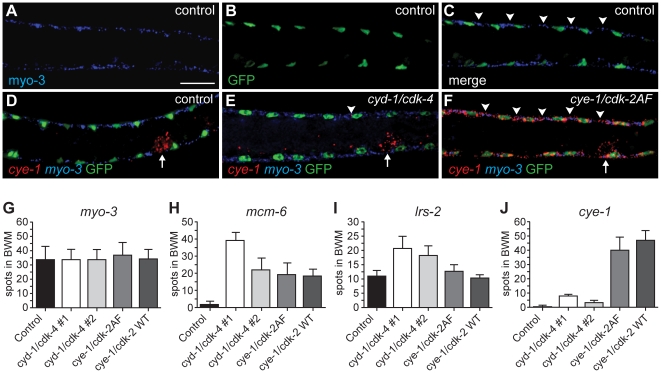
Single molecule FISH shows gene expression in individual muscle cells and limited cye-1 induction by CYD-1/CDK-4.(A-F) Single mRNA molecules labeled with probes against myo-3 (blue) or cye-1 (red) mRNA. Muscle nuclei are marked in green by myo-3::H2B::GFP. Analyzed are strains expressing only Pmyo-3::H2B::GFP (control, SV859: A-D), and Pmyo-3::H2B::GFP together with Pmyo-3::CYD-1/CDK-4 (SV857: E) or Pmyo-3::CYE-1/CDK-2AF (SV858: F). Arrowheads indicate areas of myo-3 mRNA (C) or cye-1 mRNA (E, F) expression in dorsal body-wall muscle cells. Arrows in (D-F) indicate cye-1 expression in the gonad. Scale bar indicates 10 µm, all panels show the same magnification. (G-J) Quantification of the number of fluorescent spots in seven body-wall muscle cells located anterior of the gonad on the dorsal side of animals. All animals were hybridized with myo-3 probes to identify body-wall muscle cells. Signal corresponding to mRNA molecules of myo-3 (G), mcm-6 (H), lrs-2 (I), or cye-1 (J) were counted. The strains analyzed are SV859 (control), SV857 (cyd-1/cdk-4 #1), SV860 (cyd-1/cdk-4 #2), SV858 (cye-1/cdk-2AF) and SV861 (cye-1/cdk-2WT). Note that overlap between spots greatly reduced the counted number of myo-3 and mcm-6 mRNAs. In contrast, the few and small cye-1 labeled spots are likely all single mRNA molecules.